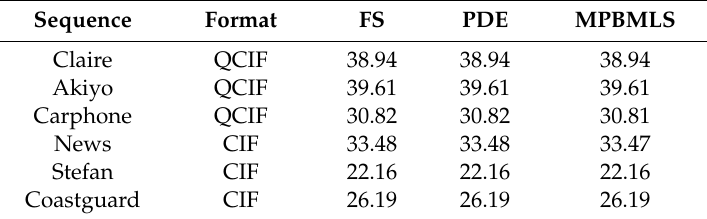
Table 4. Mean PSNR with 50